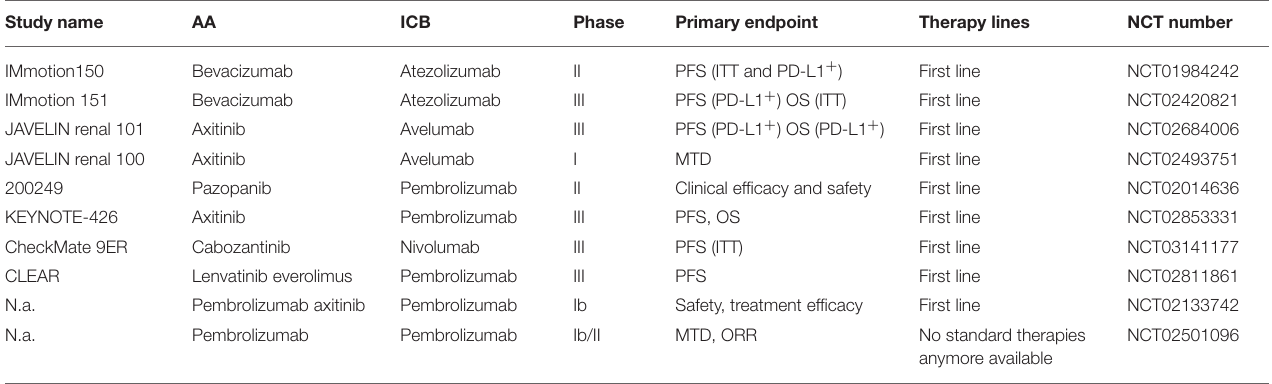
TABLE 1 | Ongoing clinical studies combining AA and immunotherapies in